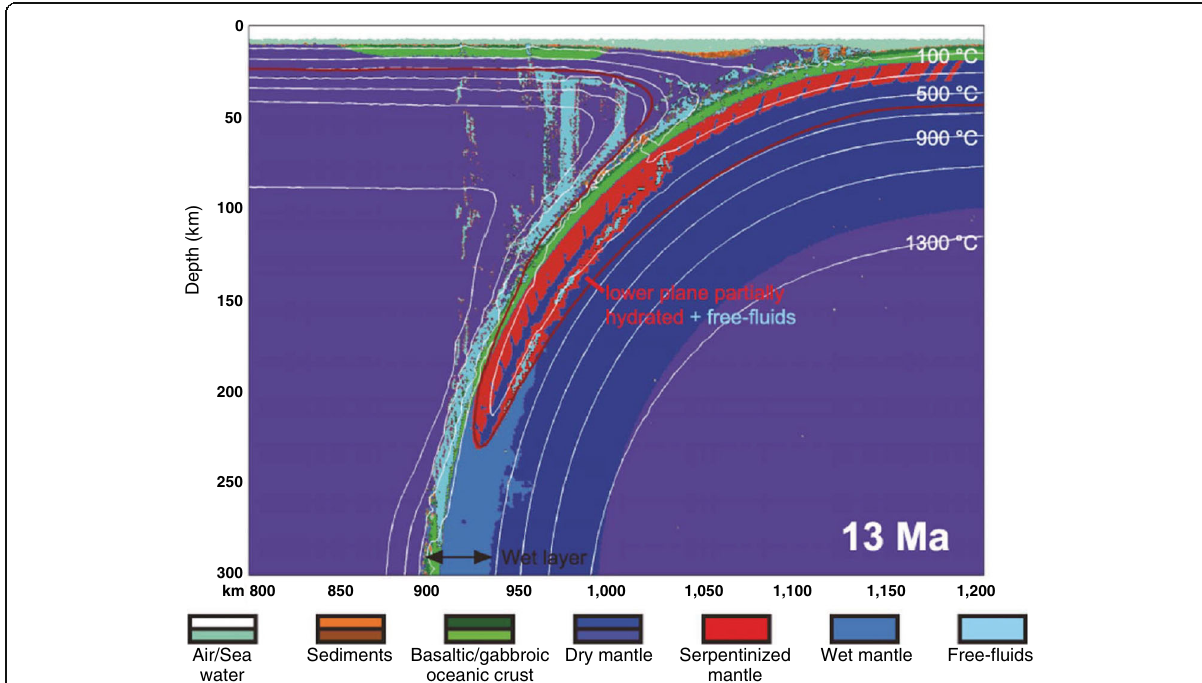
Fig. 22 Simulated hydration and dehydration of the subducting slab. Shown is an example of simulation results of a dynamic thermomechanical – petrological model that shows the hydration and dehydration of the slab caused by its subduction and bending/unbending stresses. A snapshot of the hydration and dehydration at 13 Ma after subduction is shown on an across-arc vertical cross-section of the case in which an oceanic plate with an age of 52 Ma is subducting. White lines are isotherms. (After Faccenda et al.